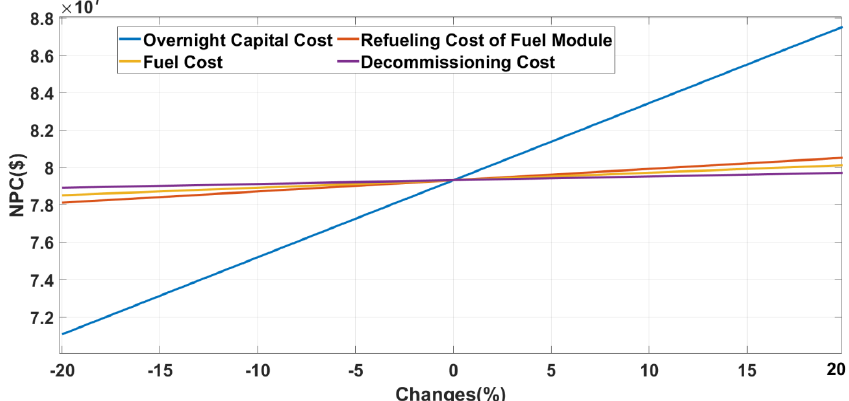
Figure 24. Impact on NPC due to variation in MR cost.